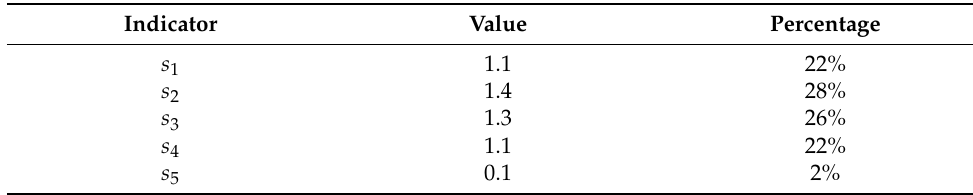
Table 1. Individual contributions to the strength indicator. Indicator